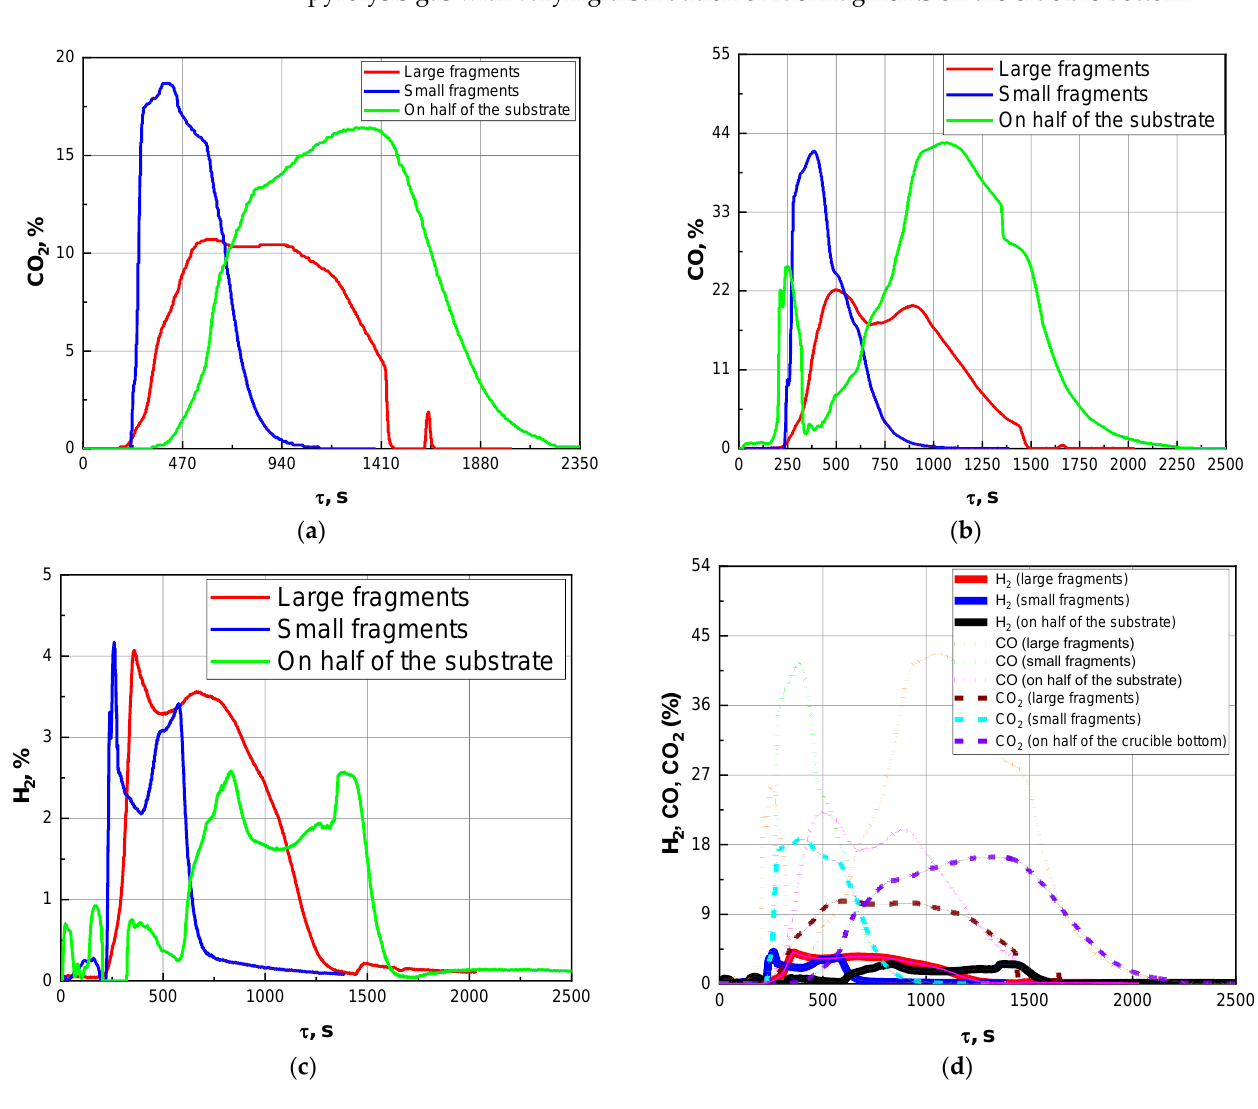
Figure 11. Trends of the concentrations of gas mixture components when varying the distribution of fuel fragments in the crucible: as a set of large fragments ( a ); as a set of small fragments ( b ); on half of the crucible bottom ( c ); comparison of gas concentrations ( d ).